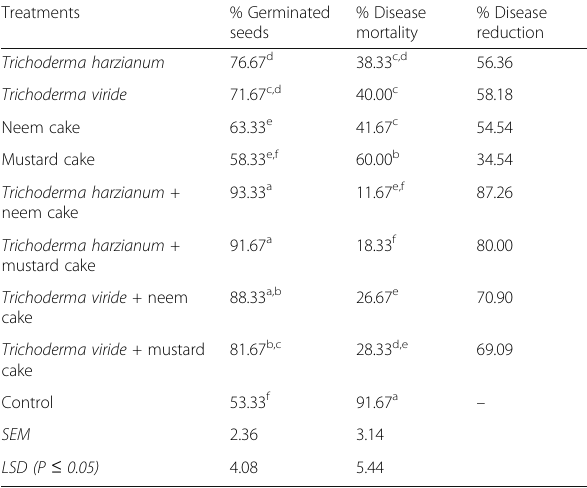
Table 1 Effect of the application of the tested bioagents and organic amendments on germination percentage and percent disease mortality